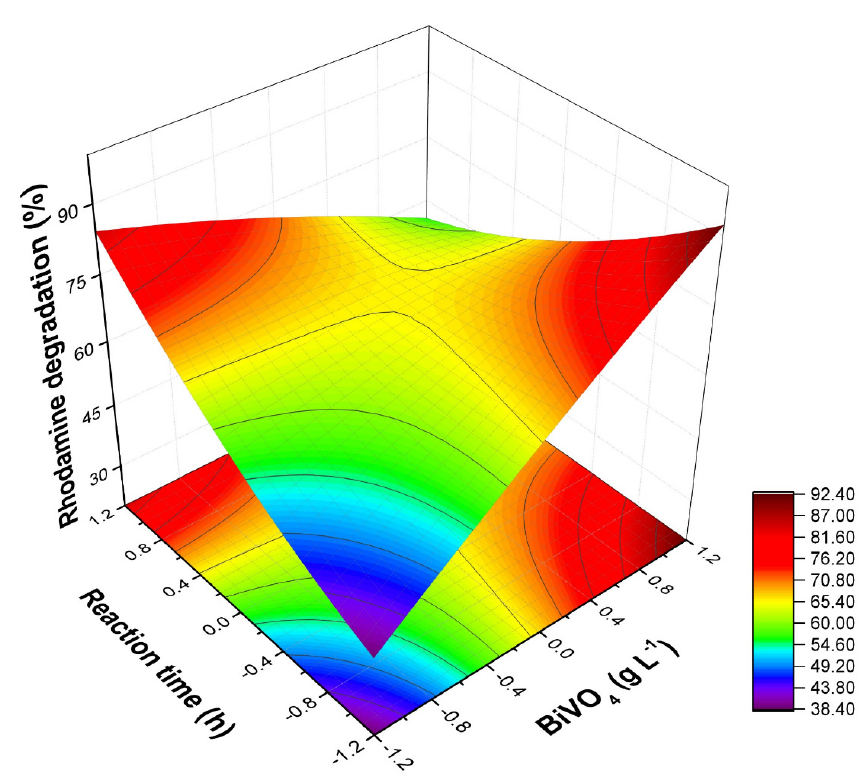
Figure 1. Response surface for the variables’ contact reaction time with the semiconductor and BVO concentration.